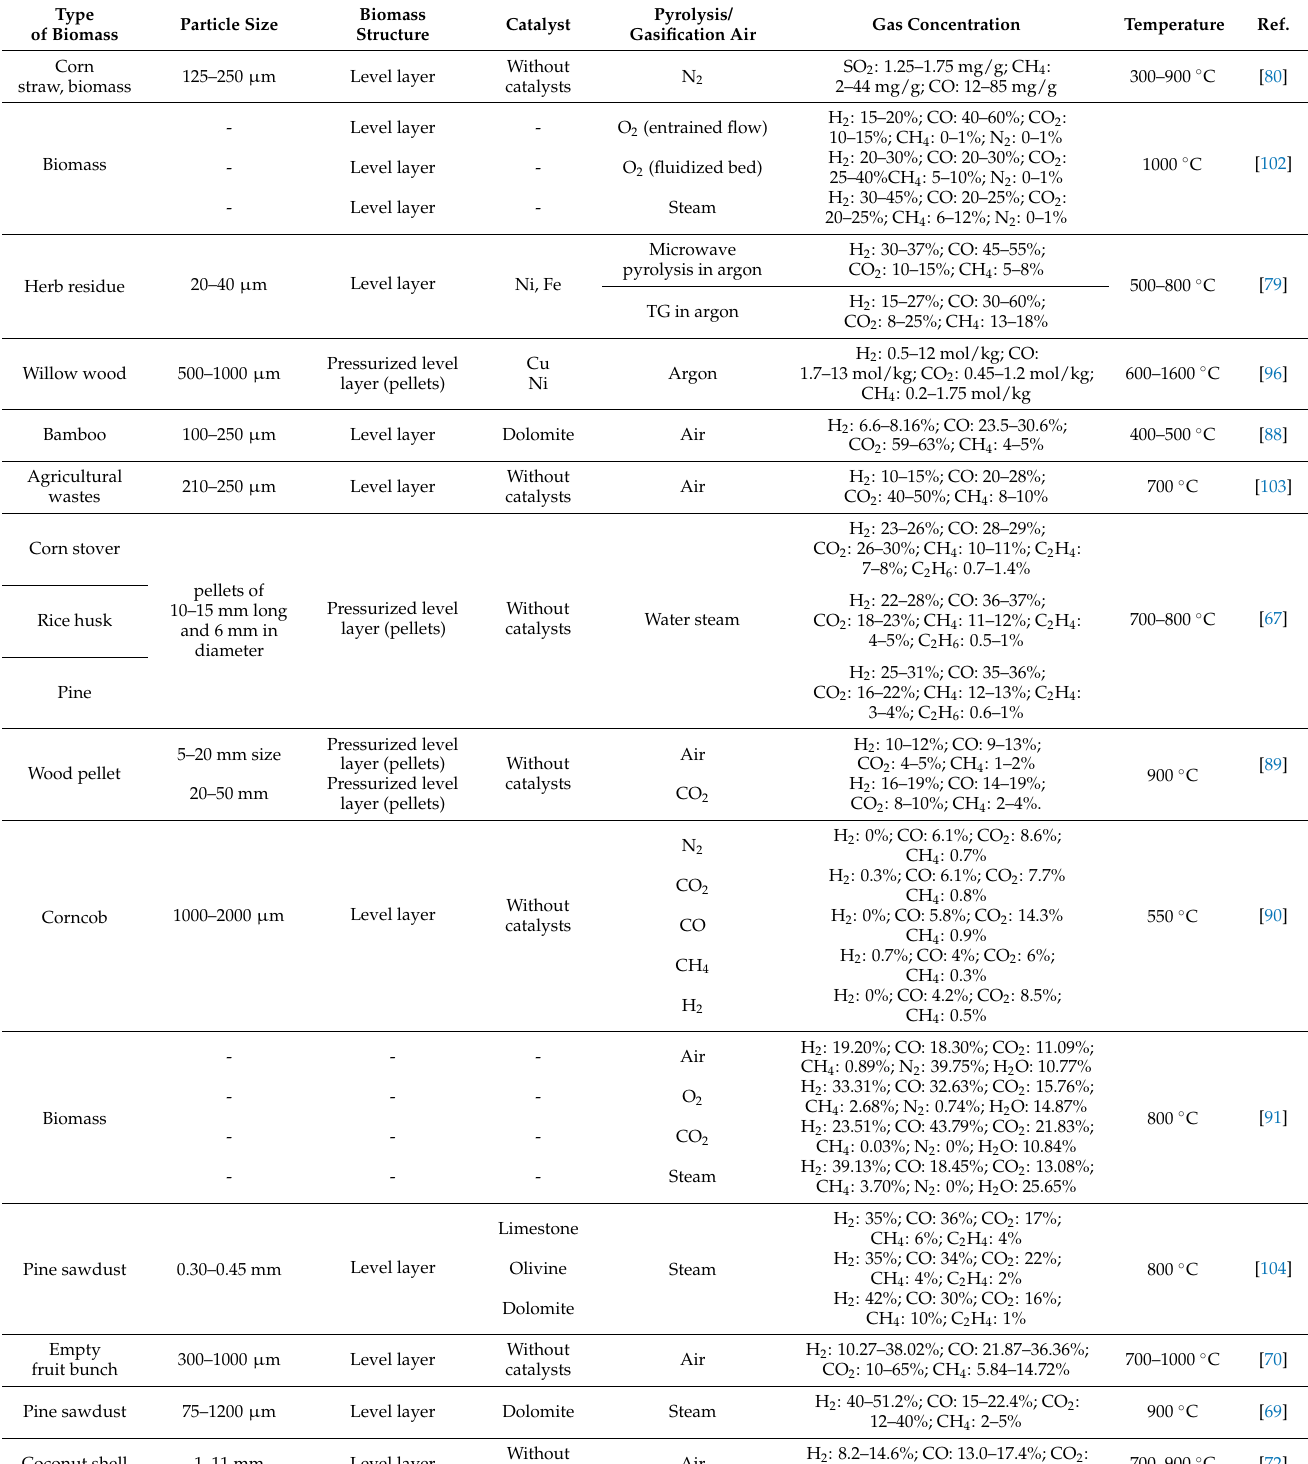
Table 8. Review of data on biomass pyrolysis and